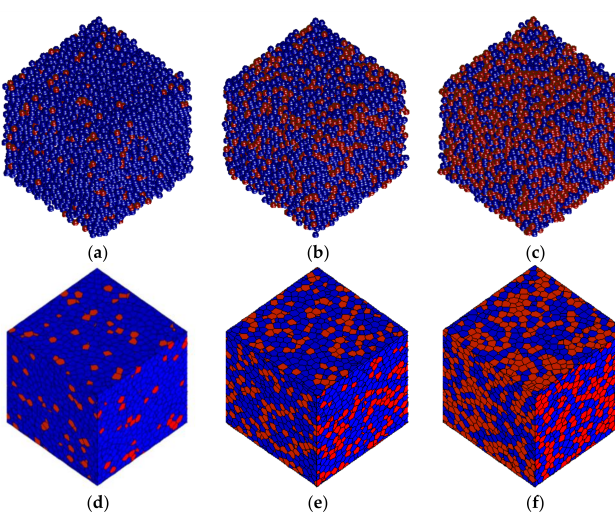
Figure 2. Simulated DP steel microstructure ( d – f ) and initial RCPS ( a – c ), with an increasing volume fraction of ferrite phase, i.e., 10%, 30%, and 50%.